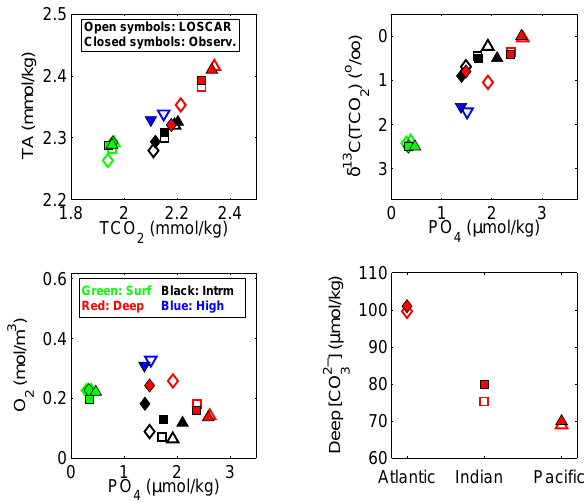
Fig. 5. Computed model tracers and observations used for LOSCAR parameter tuning for modern (preindus- trial)configuration,seetextfordetails.